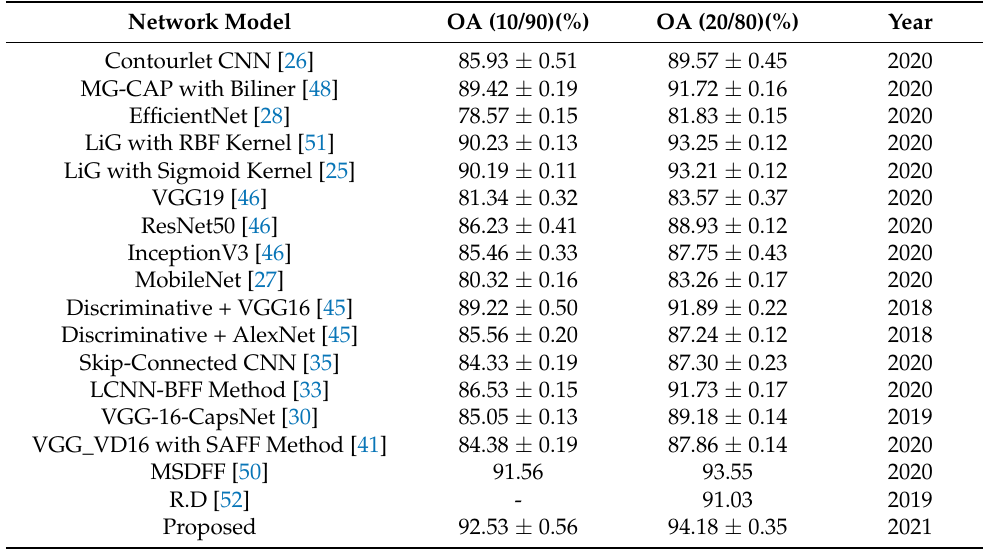
Table 9. OA (%) of seventeen methods and the LCNN-CMGF method at the training ratios of 20% and 10% in the NWPU45 dataset.